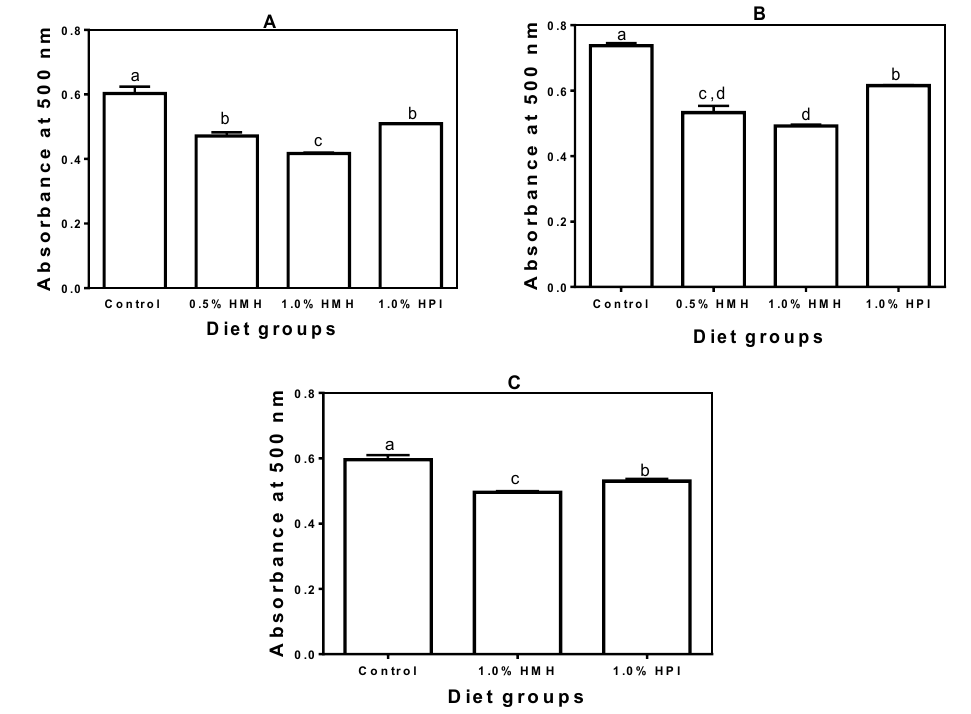
Figure 5. Total peroxide levels in plasma of ( A ) young growing spontaneously hypertensive rats (SHRs) (Trial I), ( B ) adult SHRs with established hypertension (Trial II) and ( C ) normotensive rats (Trial III) with a casein-only diet or casein diet that contained hemp seed meal protein hydrolysate (HMH) or hemp seed protein isolate (HPI). Bars with different letters have mean values that are significantly different ( p < 0.05). Values are means ( n = 4 rats) ±